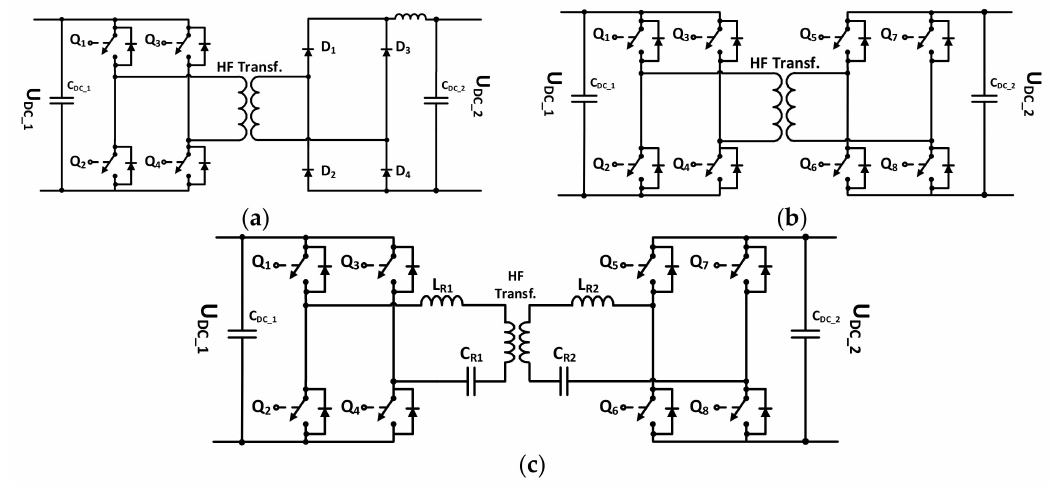
Figure 4. Block schemes of the considered DC/DC converter topologies: ( a ) single active bridge (SAB); ( b ) dual active bridge (DAB); ( c ) DAB-CLLC resonant